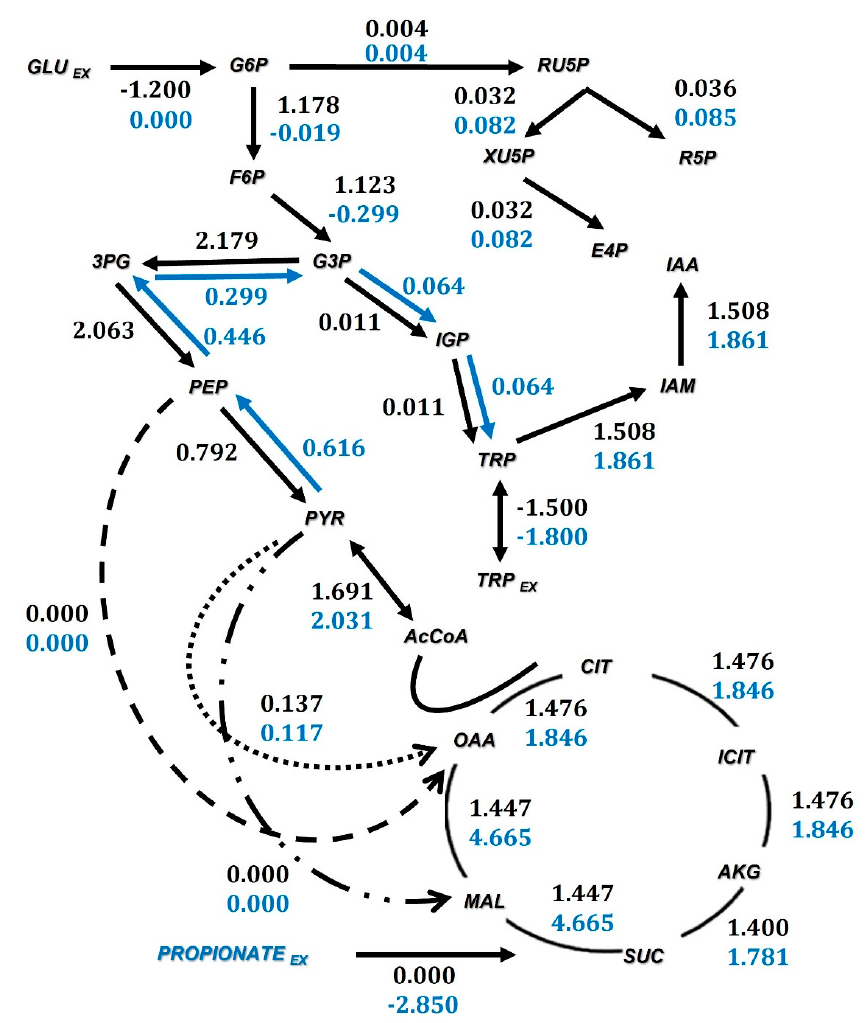
Figure 3. Flux distribution in the central carbon metabolism. Numbers in black are the fluxes when glucose is the carbon source and blue numbers when propionate is the carbon source. These fluxes are calculated in the stationary growth phase with units of mmol/(gDW h). The set of reactions are annotated in Appendix A.